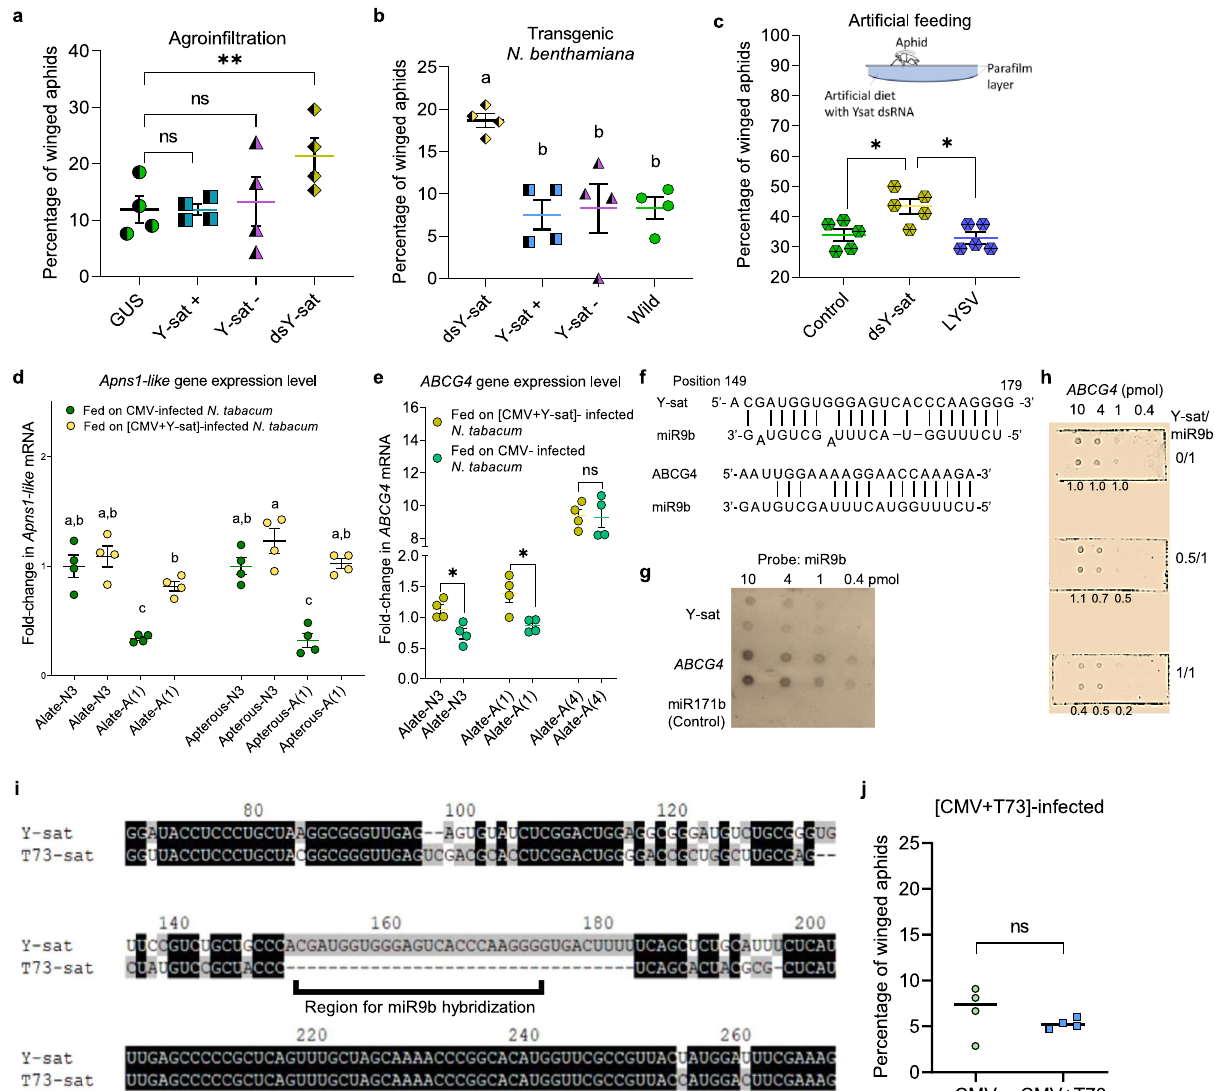
Fig. 4 Effect of Y-sat on alate formation. a Mean percentages of winged aphids in N. benthamiana transiently expressing Y-sat dsRNA (dsY-sat), plus- sense (Y-sat + ) and minus-sense RNA (Y-sat − ) relative to respective controls (one-way ANOVA, Dunnett ’ s test, n = 4, P = 0.0026). Agrobacterium carrying pBE2113-GUS was used as a control. b Mean percentages of winged aphids on transgenic plants expressing either dsY-sat, Y-sat + or Y-sat − (one- way ANOVA, Tukey ’ s test, n = 4, P = 0.0030). c Proportion of alate morphs fed on diet containing dsY-sat (one-way ANOVA, Tukey ’ s test, n = 5, P = 0.0085). Controls: leek yellow stripe virus dsRNA; H 2 O. d Relative expression of Apns1-like in aphids fed on CMV-infected or [CMV + Y-sat]-infected plants. Third instars (N3) and early adult [A(1)] are as explained in Fig. 2a (one-way ANOVA, Tukey ’ s test, n = 4, P < 0.0001). e Relative expression of ABCG4 in N3 (two-sided t test, n = 4, P = 0.0122), A(1) (two-sided t test, n = 4, P = 0.0150) and late adults [A(4)] (two-sided t test, n = 4, P = 0.8923) fed on CMV-infected or [CMV + Y-sat]-infected tobacco plants. Each data point in Fig. 4e represents the level of mRNA isolated from aphids [N3, ten individuals; A(1) and A(4), one individual]. f Complementarity between miR9b and Y-sat or ABCG4 . g RNA dot-blot hybridization. RNA oligonucleotides of Y-sat and ABCG4 complementary to miR9b shown in Fig. 4g were synthesized, blotted onto a nylon membrane (0.4 – 10 pmol) and probed by Dig-labelled miR9b. h Competitive hybridization assay. When ABCG4 RNA was probed with Dig-miR9b, Y-sat RNA was added at molar ratios indicated on right. Results were the same in two repeated experiments. Values on membrane are relative values determined using ImageJ, without Y-sat was set to 1.0. i RNA sequence alignment between Y-sat and T73 satellite (T73-sat). The complementary region to miR9b in Y-sat is indicated. j Mean percentages of alate morphs infesting CMV-infected or [CMV + T73]-infected tobacco. (GLM test in R, n = 4, z = − 0.473, P = 0.636). Each data point in ( a – c ) and ( j ) represents the percentage of winged aphids. Values followed by the same letters in ( b ) and ( d ) are not signi fi cantly different. **, P < 0.01; *, P < 0.05; ns, not signi fi cant. Source data are provided as a Source Data fi